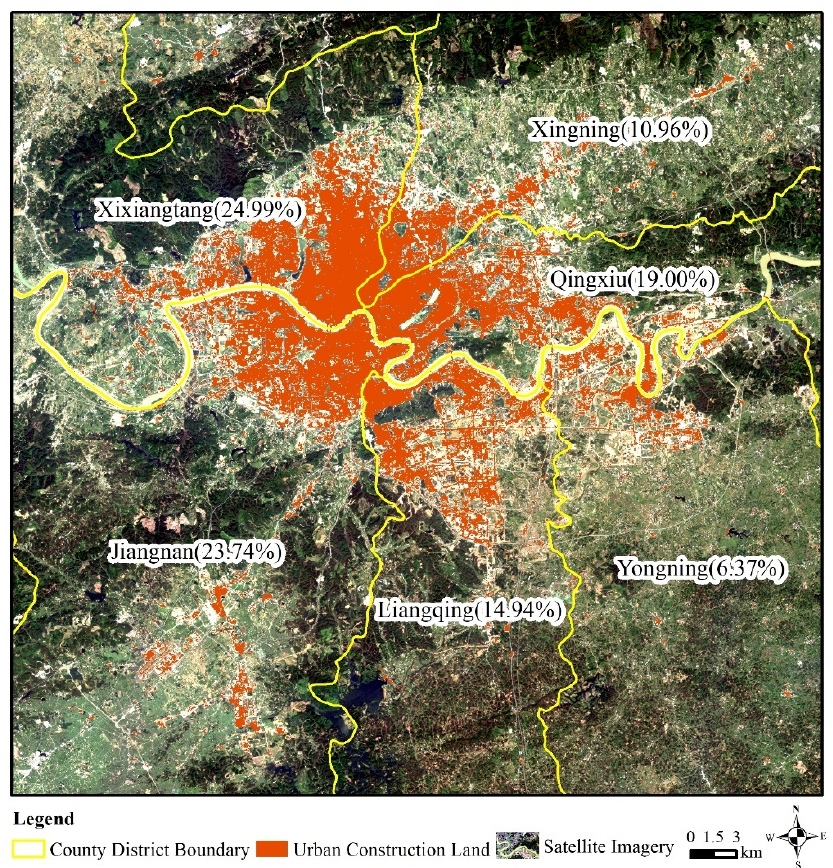
Figure 2. Spatial distribution of urban construction land of Nanning in 2021.